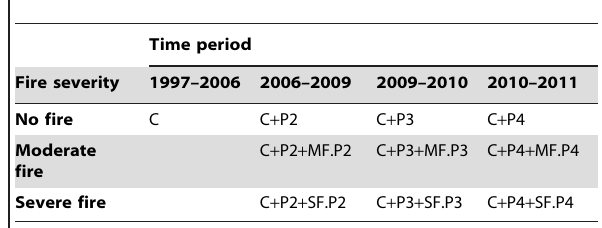
Table 1. The overarching modelling framework used to quantify relationships between period and fire and the mortality and collapse of large cavity trees.